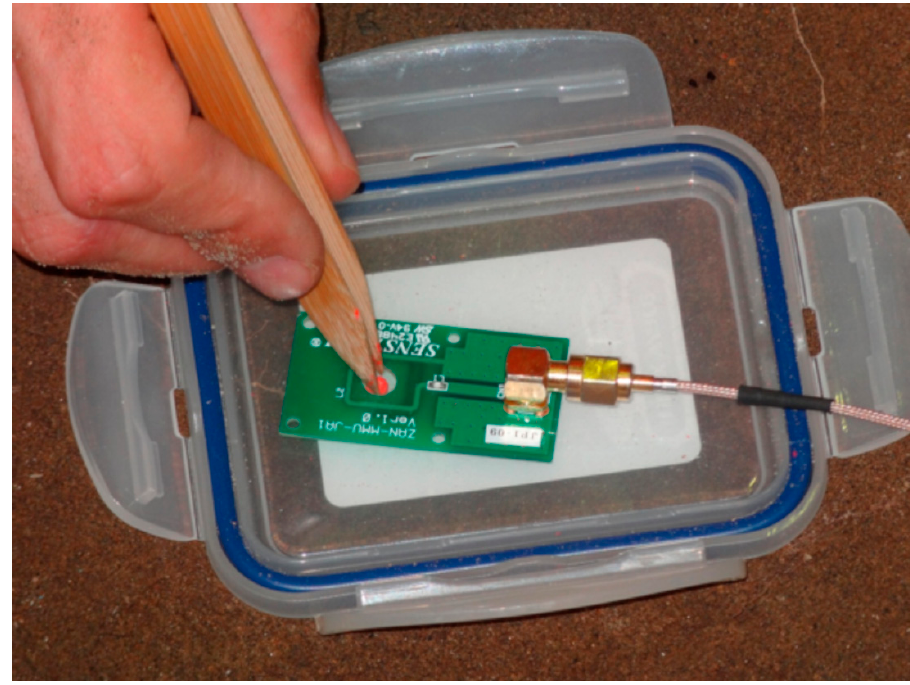
Figure 3. An artificial gravel particle used in the first experiment shown within the Radio-Frequency Identification reader.